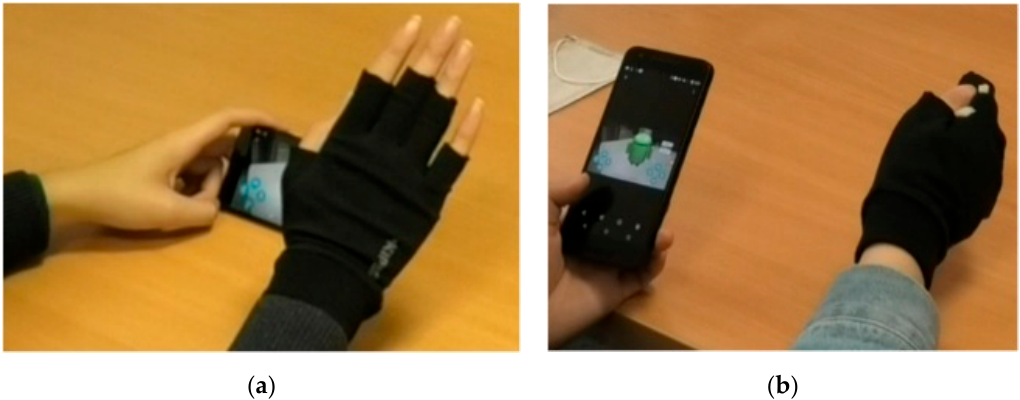
Figure 3. Variety of gestures performed by our participants using one hand (right hand) while holding the device on the other hand: ( a ) wrist gestures and ( b ) thumb-to-index touch gestures.